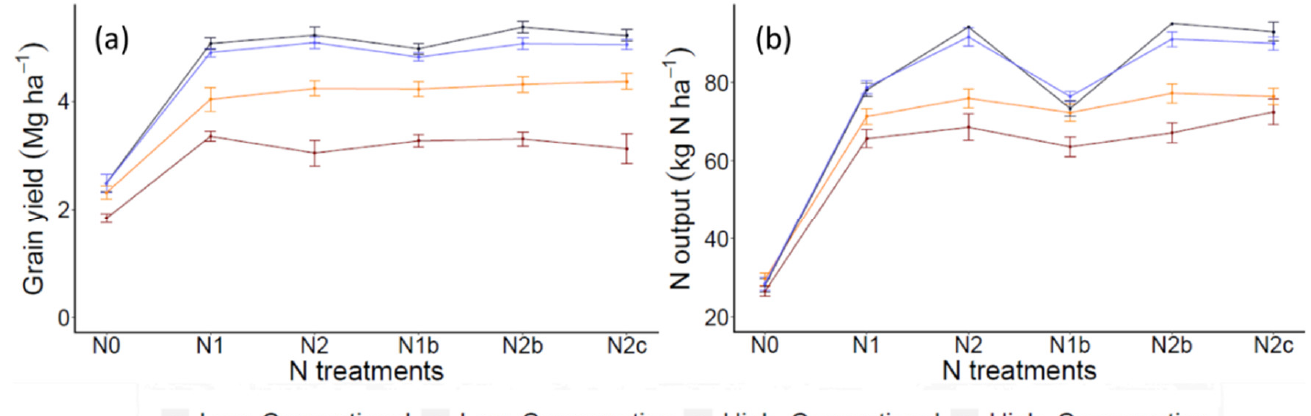
Figure 3. Wheat grain yield (Mg ha −1 , 12% moisture) ( a ) and N output (kg N ha −1 ) ( b ) for combined tillage and irrigation factors, for each N treatment, over the 4 years. Treatment N0 has no fertilizer application; N1 received 125 kg N ha −1 split one-third at sowing and two-thirds in the first post-plant irrigation; N2 received 250 kg N ha −1 split as one-third at sowing and two-thirds in the first post-plant irrigation; N1b received 125 kg N ha −1 split as two-thirds at sowing and one-third in the first post-plant irrigation; N2b received 250 kg N ha −1 split as two-thirds at sowing and one-third in the first post-plant irrigation, and N2c received 250 kg N ha −1 applied at sowing. Small bars indicate standard error.